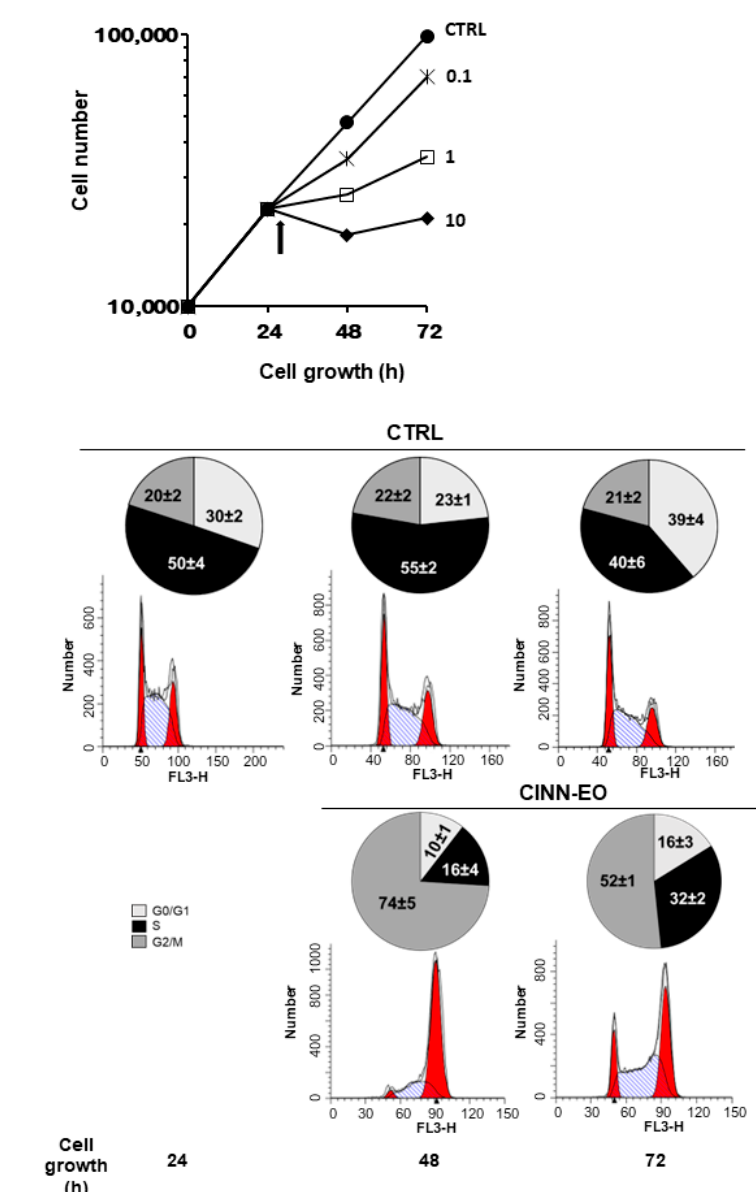
Figure 3. Anti-proliferative effect of CINN-EO on M14 melanoma cells. ( A ) Dose–response curves for CINN-EO at the indicated oil concentrations (µg/mL). CTRL, untreated cells. The values are the mean ± SD of at least three experiments. The standard deviations, when not evident, are comprised in symbols. The arrow indicates the start of CINN-EO treatment. ( B ) Effect of CINN-EO on the cell-cycle phase distribution of the M14 melanoma cell line. Cells were exposed to 10 µ g/mL CINN-EO for the indicated times. Untreated (CTRL) and treated cells were then stained with PI and analysed for DNA content by flow cytometry. The percentages ± SDs of cells in the G0/G1 (light grey), S (black) and G2/M (dark grey) phases of the cell cycle were estimated from each histogram with ModFit software. The histograms shown are representative ModFit analyses for each condition from at least three different experiments with similar results. The number reported in each panel represents the time of treatment (h).